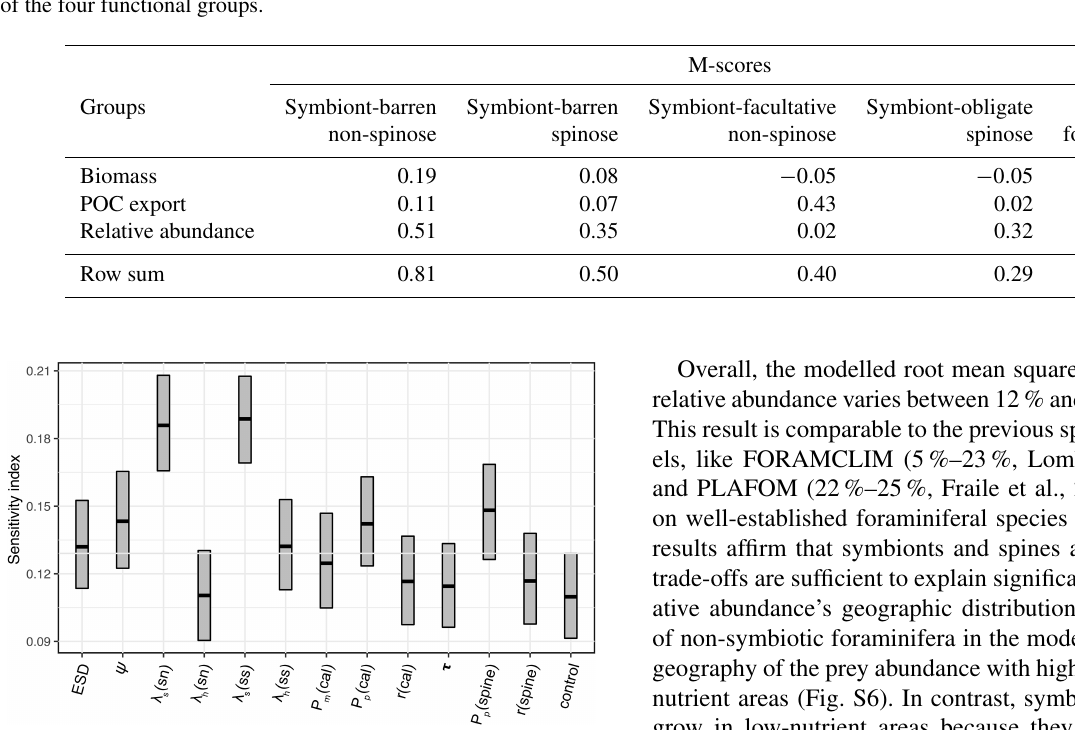
Table 3. M-score values across foraminiferal groups for the optimal parameter set. The total foraminiferal M-score is the sum of the M-scores of the four functional groups.